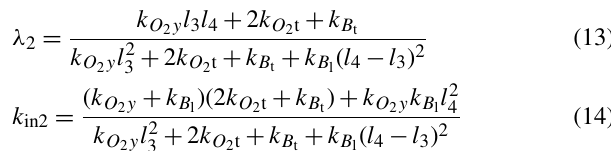
δ out = λ AR δ in F in = K in δ